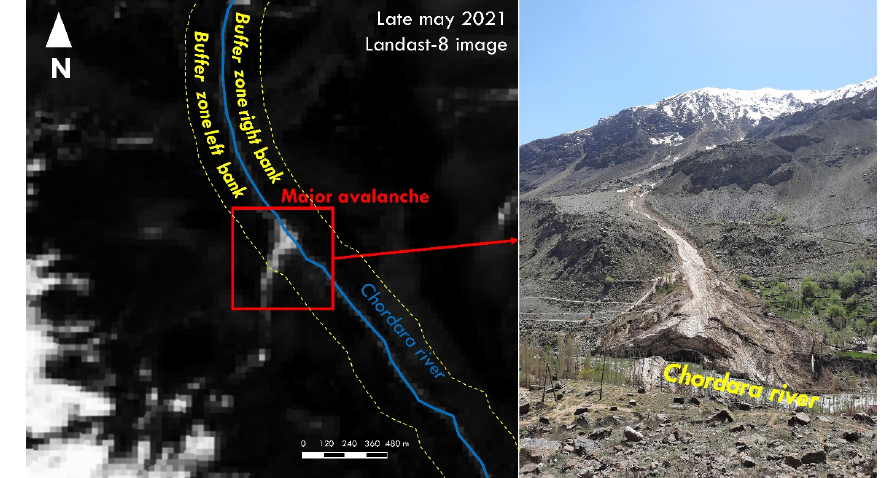
Figure 2. An illustration of avalanche depositional zone detection using a late snow season Landsat-8 image near Khorog in May 2021 (Badakhshan in Tajikistan).